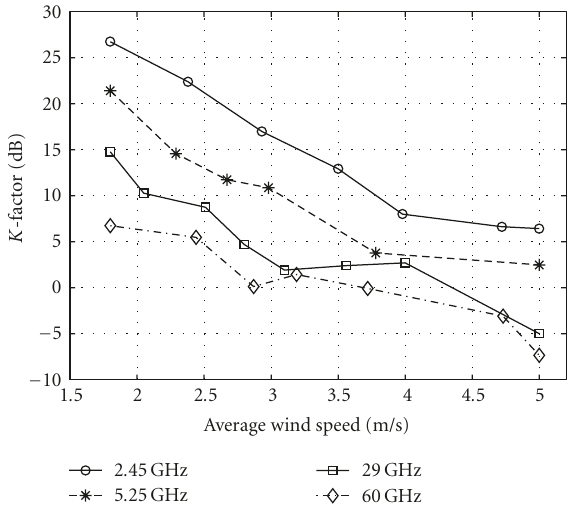
Figure 8: Ricean K -factors as function of average wind speed estimated from measurements at 2.45, 5.25, 29, and 60GHz after propagating through dry leaved deciduous trees (Site